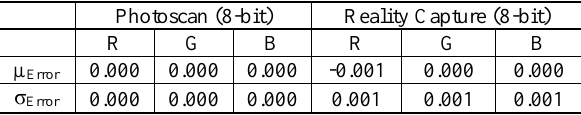
Table 1. 8-bit colour errors (measured in tones) of a colour chart measured before and after processing the images in Agisoft Photoscan (2018) and Capturing Reality Capture (2018)